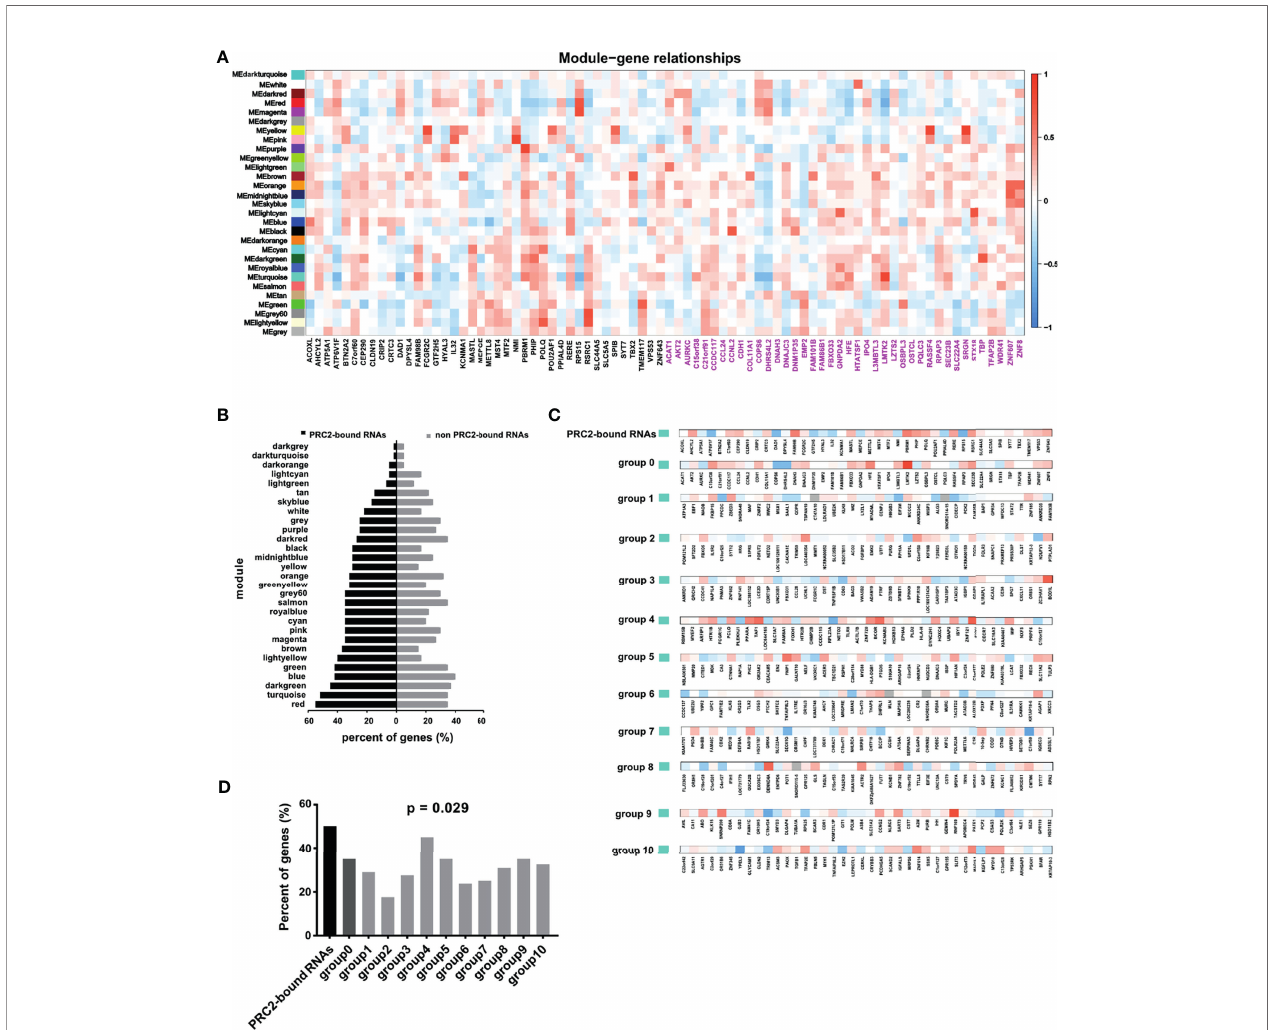
FIGURE 3 | WGCNA con fi rming PRC2-bound RNAs are associated with histone modi fi cation. (A) WGCNA analyzing the relationships between modules and PRC2- bound transcripts or control transcripts. The correlation coef fi cient is shown as color intensity. Red indicates positive correlation, and blue indicates the opposite. The genes with black color represent PRC2-bound transcripts, and genes with magenta color represent control genes with their expression nearest to PRC2-bound transcripts. (B) Analyzing the proportion of related genes in the PRC2-bound transcripts or control genes of each module in panel (A) . The related gene is de fi ned as the absolute of correlation coef fi cient greater than 0.2 and p < 0.05. (C) The relationship between the turquoise module and PRC2 binding RNAs (line 1), or control genes with their expression nearest to PRC2 binding RNAs (group 0), or control genes selected randomly (groups 1 – 10). The correlation coef fi cient is shown as color intensity. Red indicates positive correlation, and blue indicates the opposite. (D) The proportion of related genes of each group in panel (C) . The absolute value of correlation coef fi cient greater than 0.2, and p < 0.05 is indicates related genes. WGCNA, weighted gene co-expression network analysis; PRC2, polycomb repressive complex